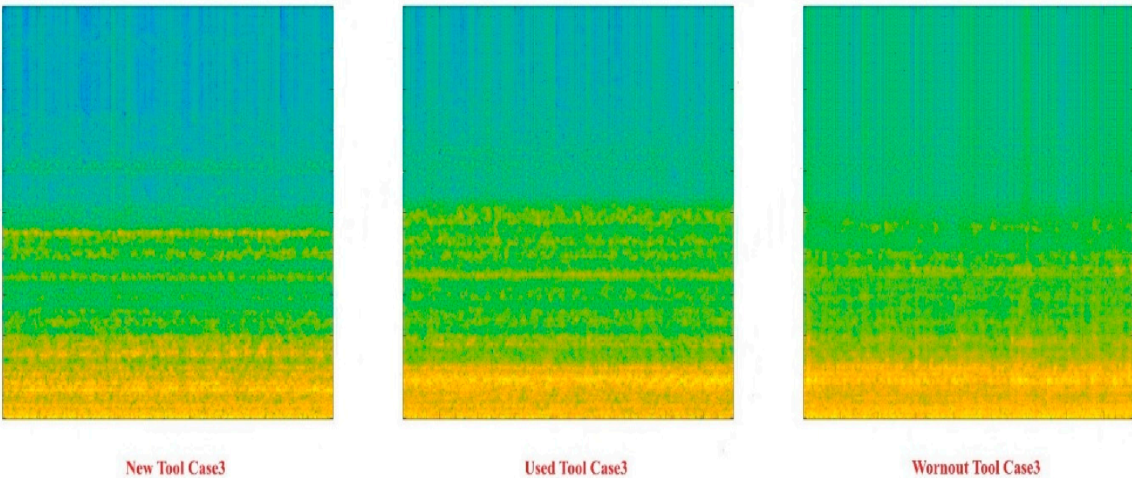
Figure 24. Spectrograms (training samples) of new, used, and worn-out tool conditions for Case